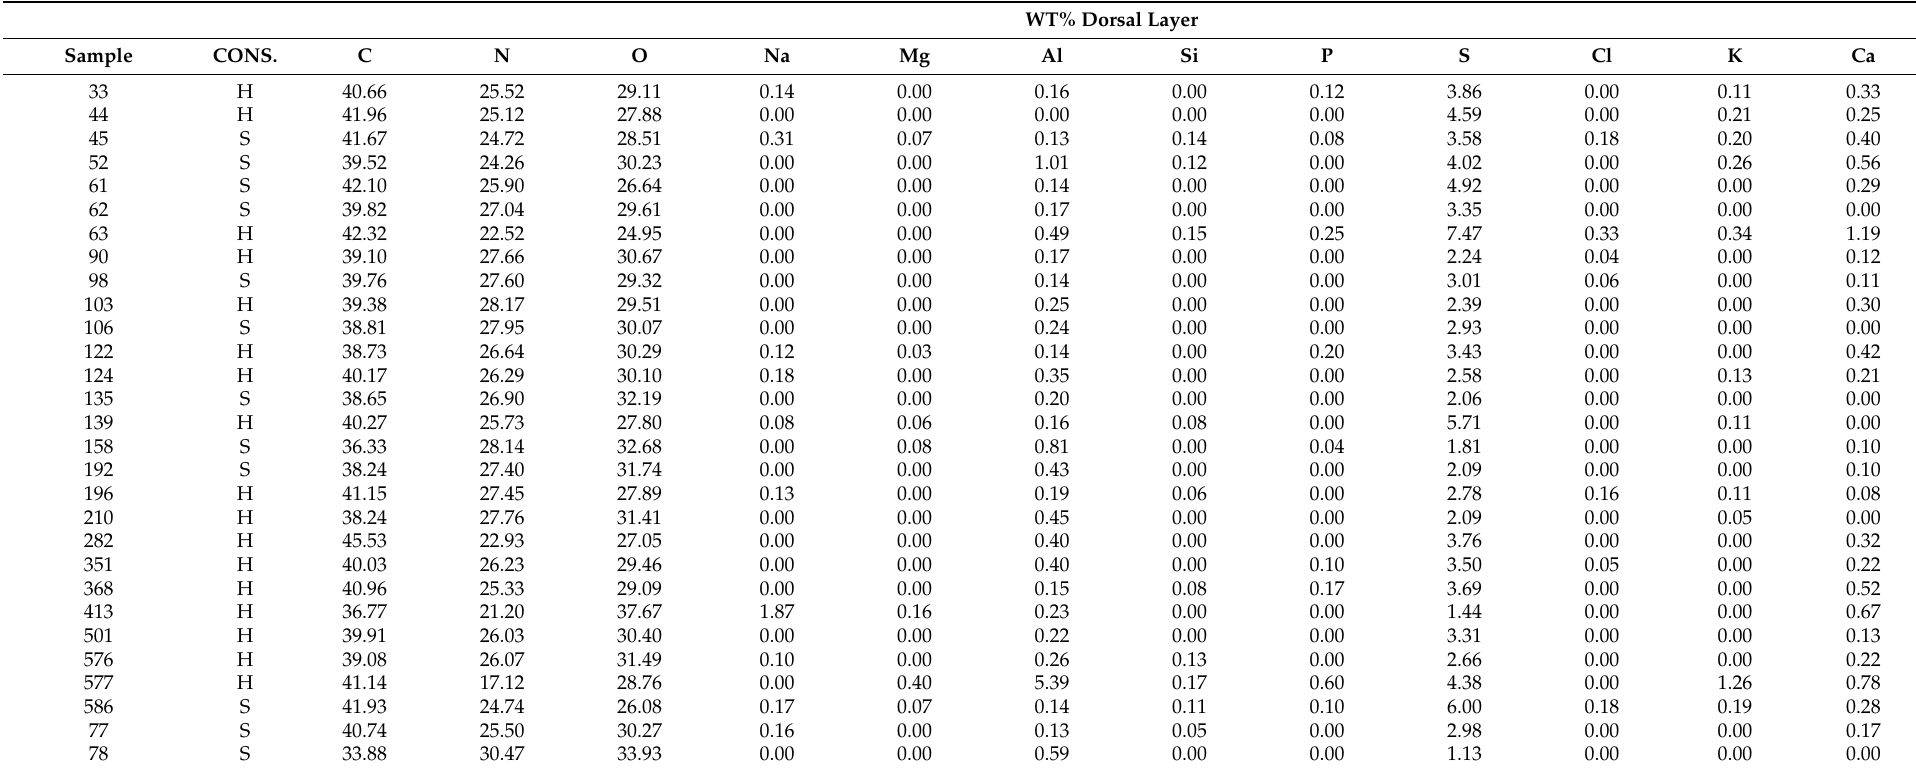
Table 2. WT% values of elements in the dorsal layer. WT%, weight percentage; CONS, consistency; C, carbon; N, nitrogen; O, oxygen; Na, sodium; Mg, magnesium; Al, aluminium; Si, silicon; P, phosphorus; S, sulphur; Cl, chloride; K, potassium; Ca, calcium; H, hard; S, soft; SD, standard deviation. WT% Dorsal